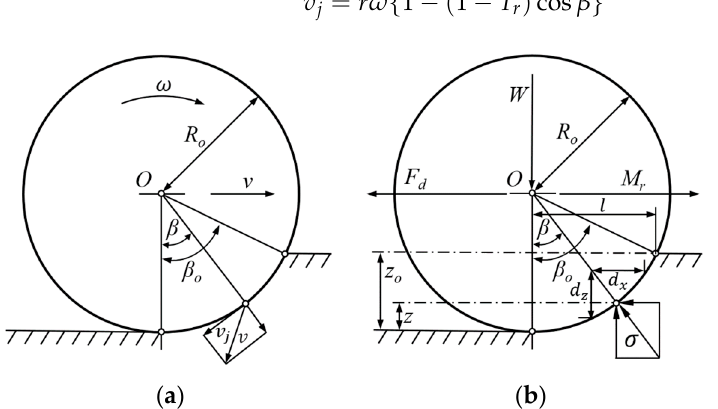
Figure 11. The schematic force diagram of shear-displacement under the wheel terrain interface (a) slip velocity 𝑣 and (b) with applied radial pressure 𝜎 .